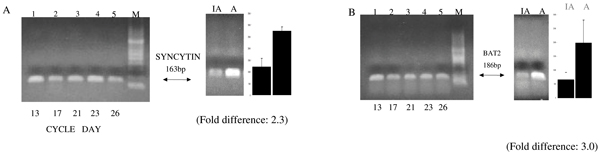
Semiquantitative PCR analyses of endometrial cDNA populations for syncytin and BAT2 (panels A and B respectively) prepared from Inadequate (IA) cycle days 13, 17, 21, 23, and 26 [66]. The side panels compare IA and Adequate (A) cDNA populations on day 23 for each gene. The column charts represent average densitometric analyses of three experiments with margins of error (SD).